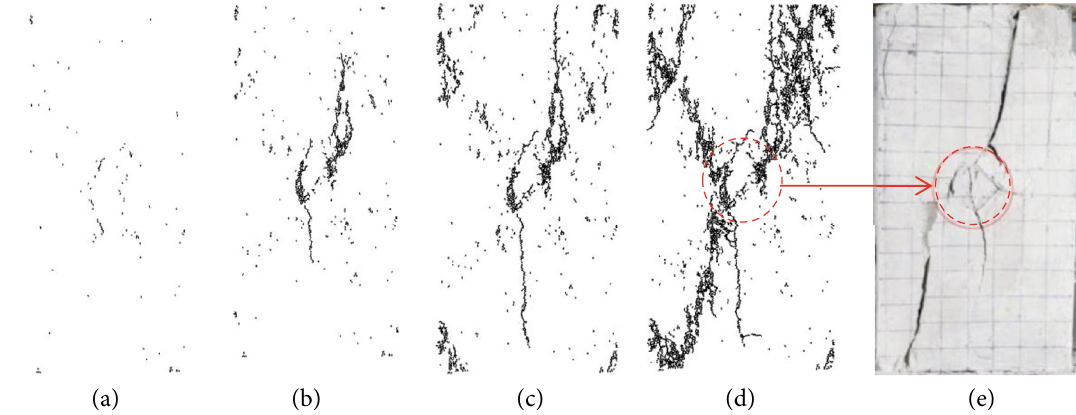
Figure 8: The process of crack initiation and development at the bend number of 1. (a) ε = 0 : 0067 . (b) ε = 0 : 0122 . (c) ε = 0 : 0183 . (d) ε = 0 : 235 . (e) Instable failure.